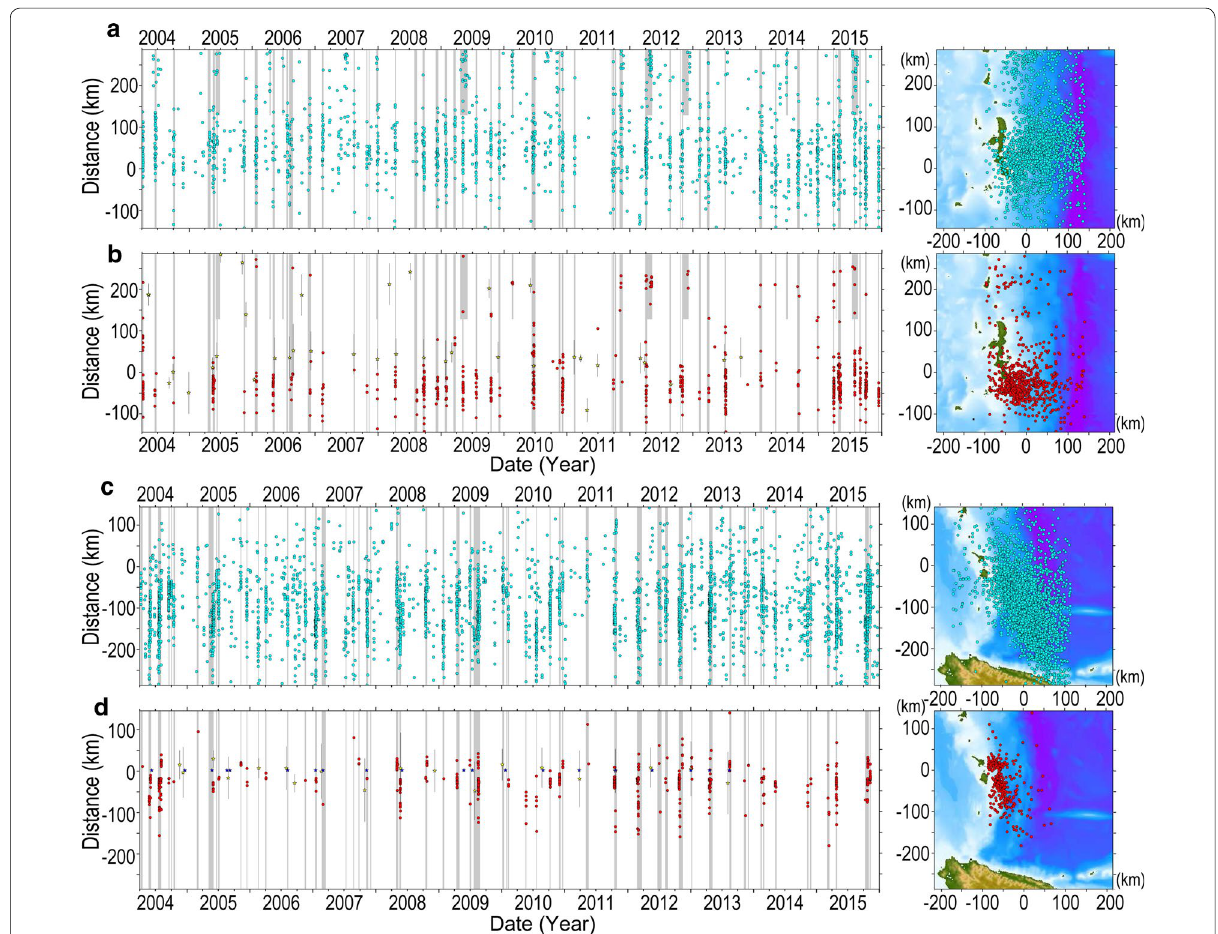
Fig. 8 Time–space plots of very low frequency earthquakes (VLFEs) and low-frequency earthquakes (LFEs). a Time–space plot of VLFEs in the Okinawa area from April 2004 to December 2015. Blue dots denote the VLFEs. The catalog of the VLFEs is based on Nakamura and Sunagawa (2015) with later events added. Vertical lines with yellow stars show the SSE faults (Nishimura 2014). Gray hatched areas show the periods for which the analyses of the LFEs were calculated. b Same as a but for LFEs. Red colors show the LFEs. c Same as a but for the Yaeyama area. d Same as b but for the Yaeyama area. Blue stars show the occurrence dates of SSEs in the Yaeyama area cataloged by Nakamura and Sunagawa